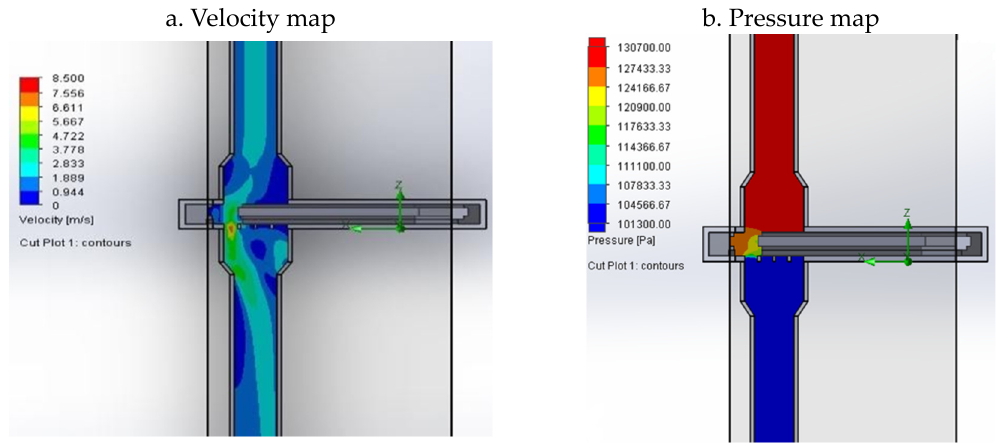
Figure 11. Second valve geometry with 30% opening.